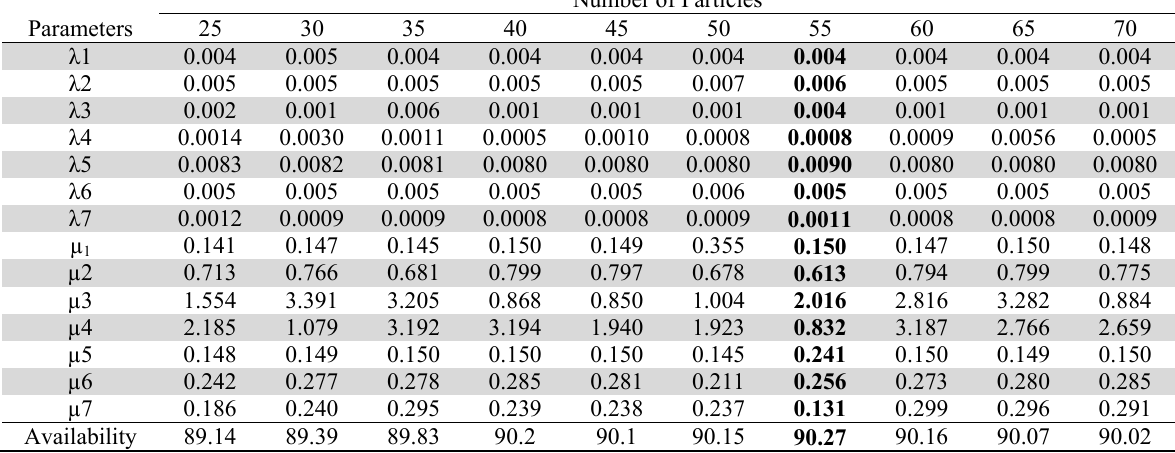
Fig. 3. Effect of Number of Particles on System Availability Effect of Number of Particles on System Availability Taking Number of Generations Constant